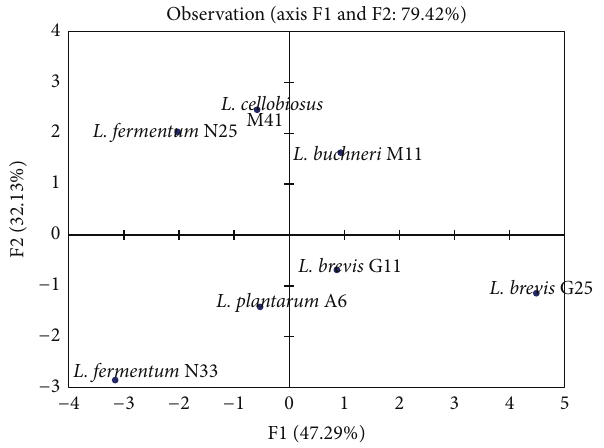
Figure 10: Distribution of LAB selected for the fermentation of Kutukutu on the axis system (F1 ×